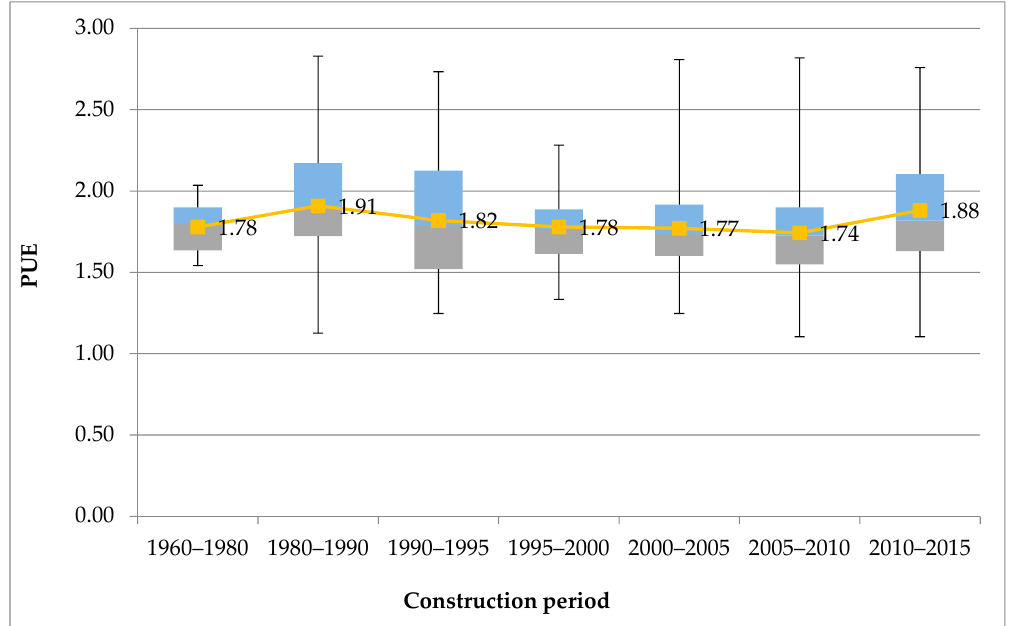
Figure 5. Average PUE per different construction periods.